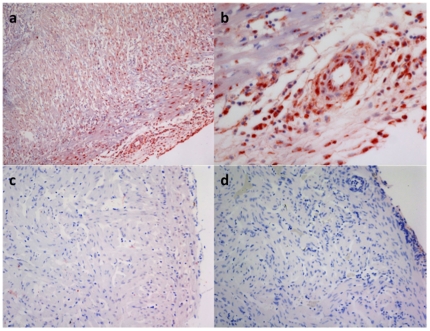

In situ hybridization was performed using locked nucleic acid (LNA) probes targeting the L2 segment of the Piscine reovirus.Sections were permeabilized using proteinase K followed by hybridisation with digoxigenin (DIG)-labeled LNA probes. Sections were incubated with a mouse monoclonal anti-DIG-horse radish peroxidase and stained using a Tyramide Signal Amplification System. Sections were counterstained with Meyer's hematoxylin solution. (a) Heart from HSMI-infected fish (10×); (b) heart from HSMI-infected fish (40×); (c) heart from non-infected fish (40×); (d) heart from a fish infected with salmon pancreas disease virus.